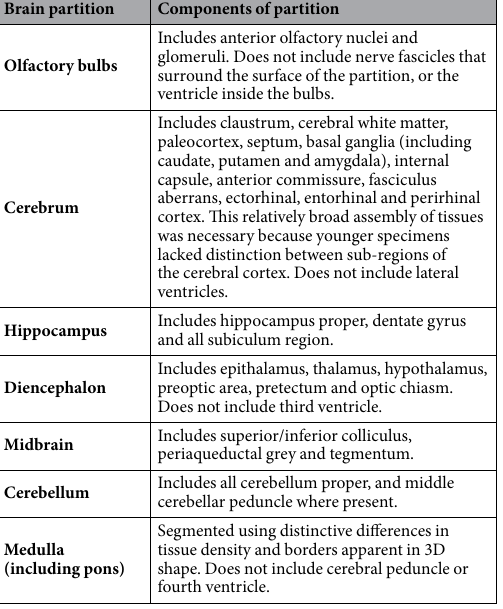
Table 6. The components included in each of the seven brain partitions used in the present study. The delineation of each partition was based on the marsupial brain atlases of Ashwell 36